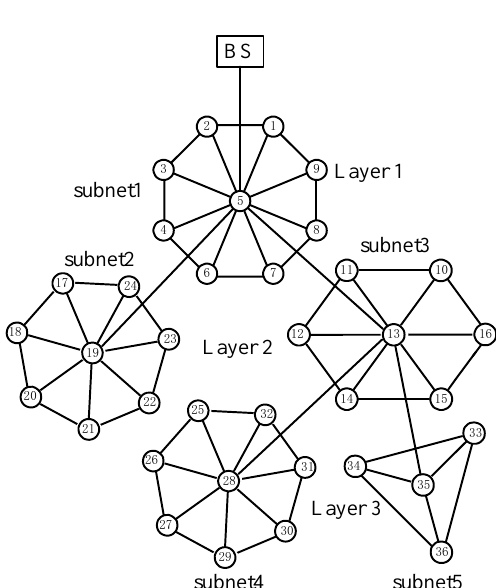
Figure 4. Result of